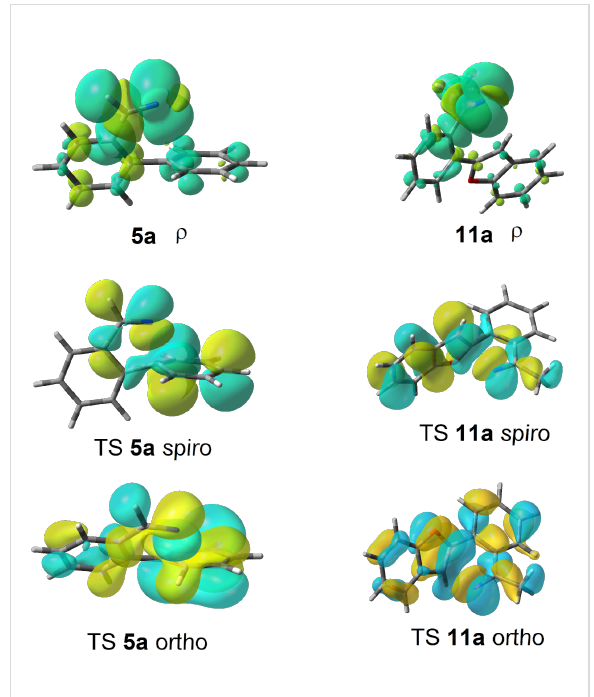
Figure 4: DFT computed structures for 5a , 11a and their cyclisation transition states (TS). Top line: spin density distribution maps for iminyls 5a and 11a . Middle line: spiro TSs, r(N···C) for 5a = 1.928 and for 11a = 2.064 Å. Bottom line: ortho TSs, r(N···C) for 5a = 1.954 and for 11a = 2.027